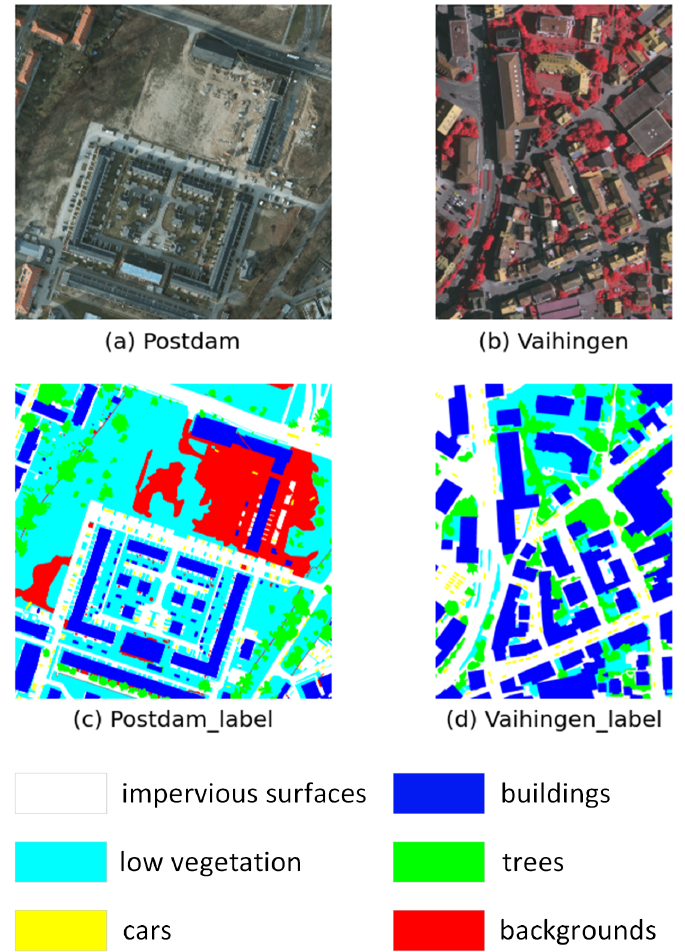
Figure 6. ( a ) Sample image of Potsdam dataset. ( b ) Sample image of Vaihingen dataset. ( c ) Ground truth of sample image of Potsdam dataset. ( d ) Ground truth of sample image of Vaihingen dataset.